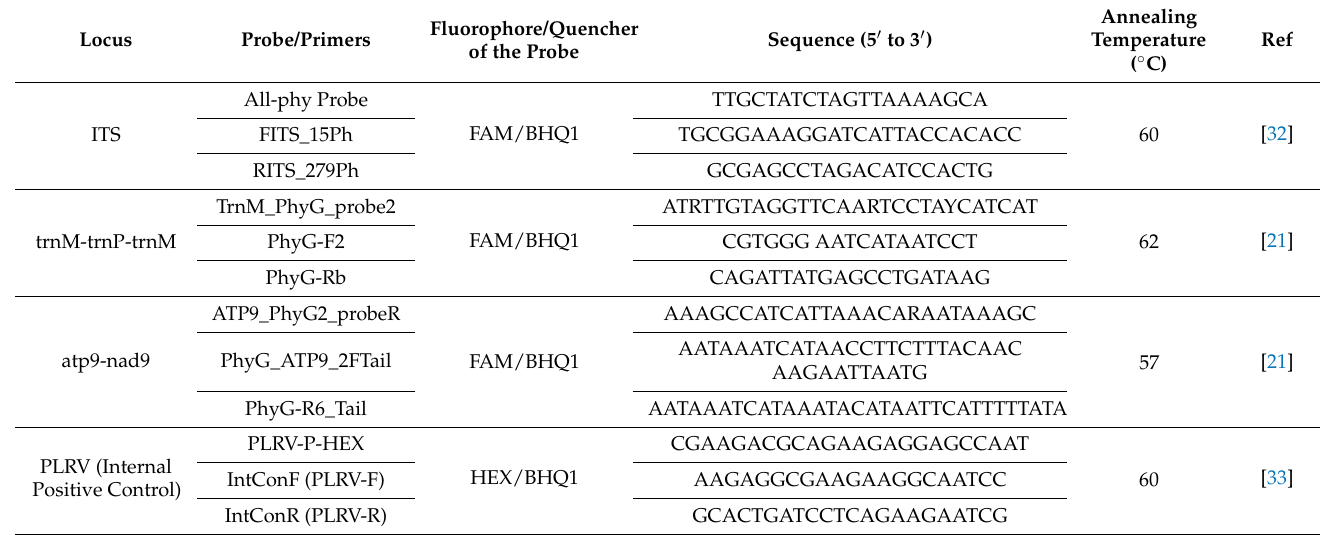
Table 1. TaqMan primers and probes used in eDNA